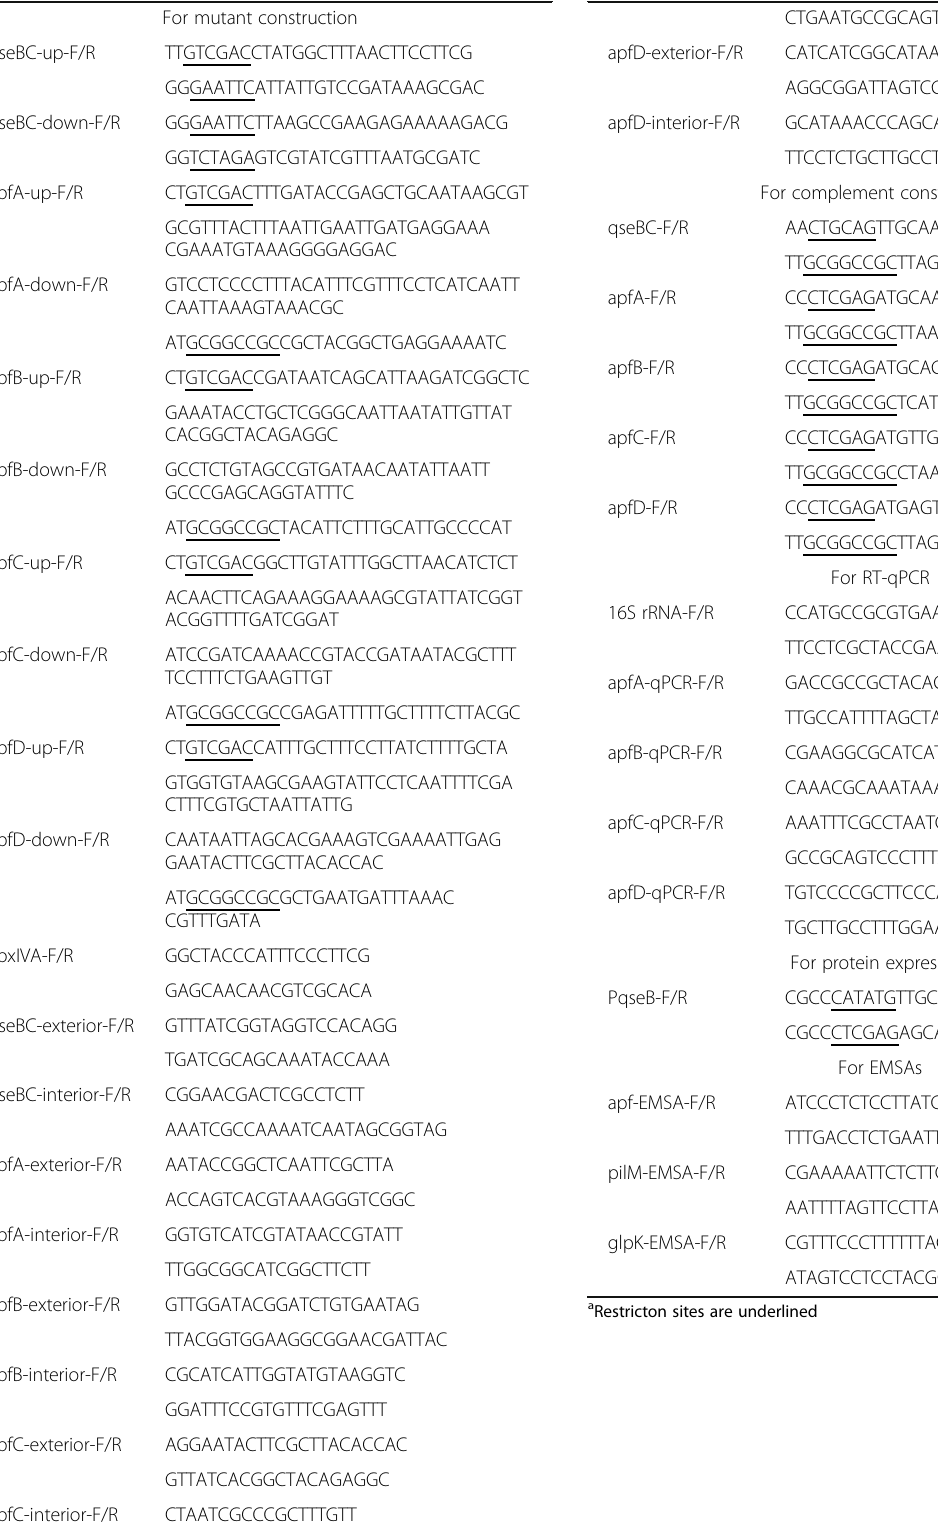
Table 2 Primers used in this study Primers